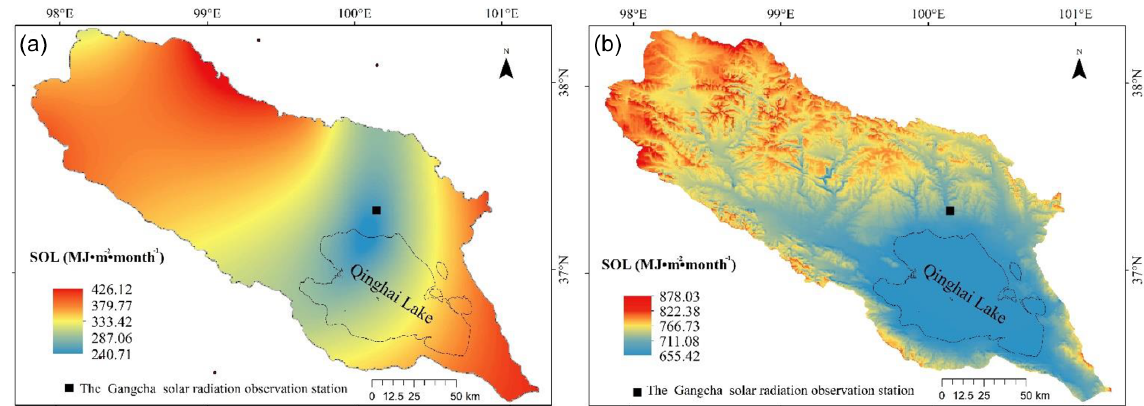
Figure 2. Spatial distribution of the total solar radiation (SOL) in July 2020. (a) SOL simulated by the Ångström–Prescott equation. (b) SOL simulated by the improved approach.